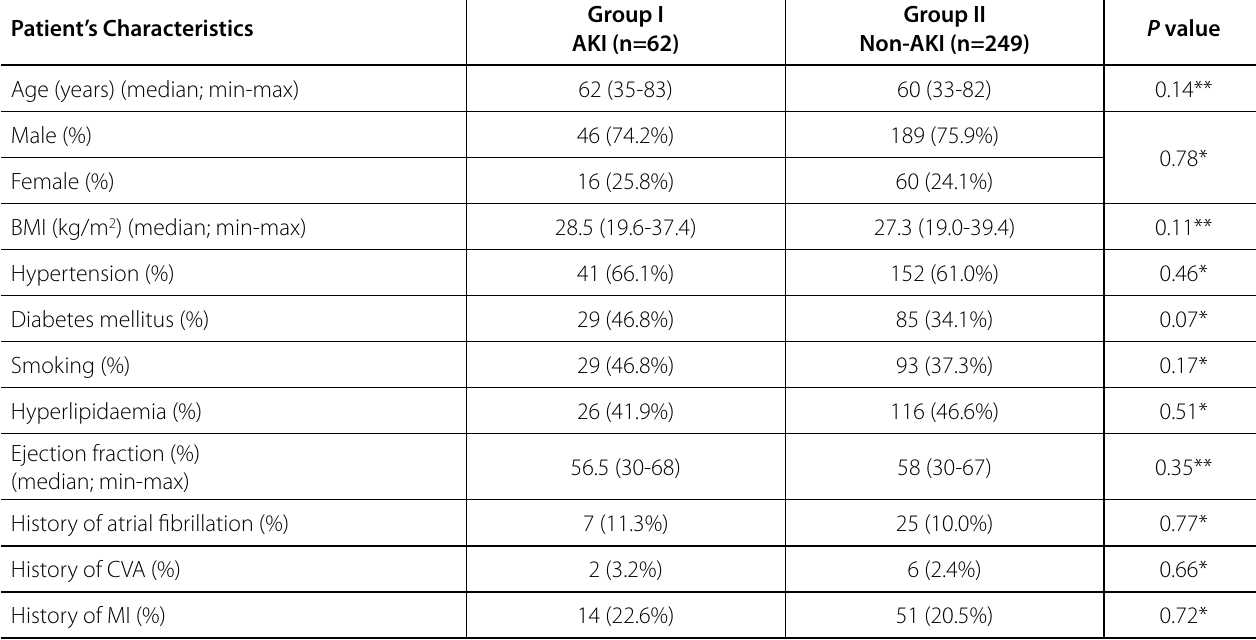
Table 1 . Comparison of patient’s characteristics between the 2 groups. Patient’s